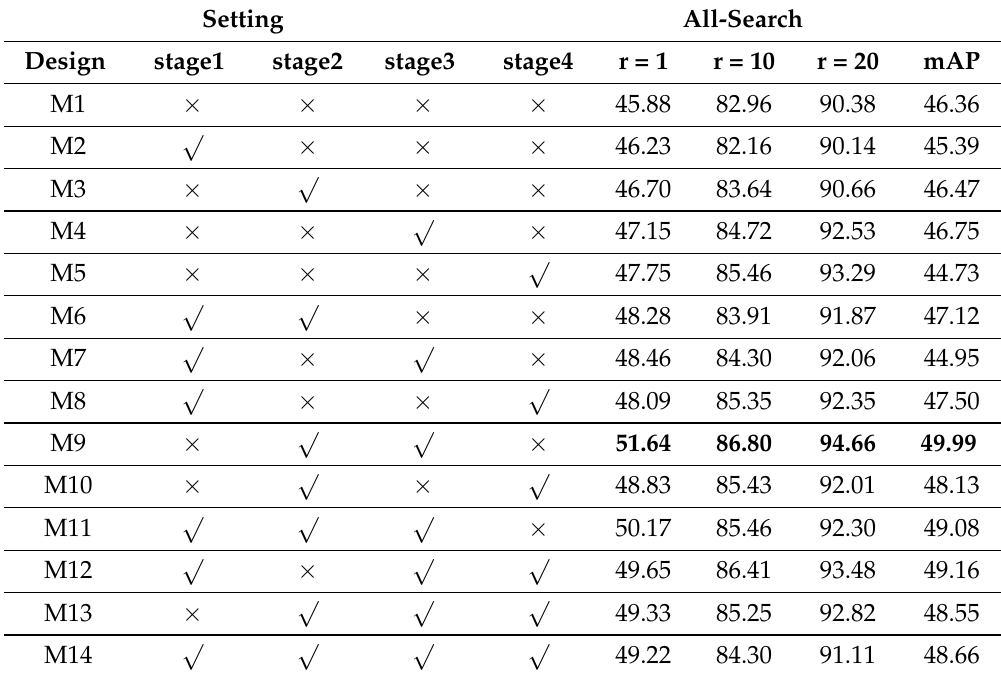
Table 4. Comparison on SGA at different convolution stages. Bold numbers are the